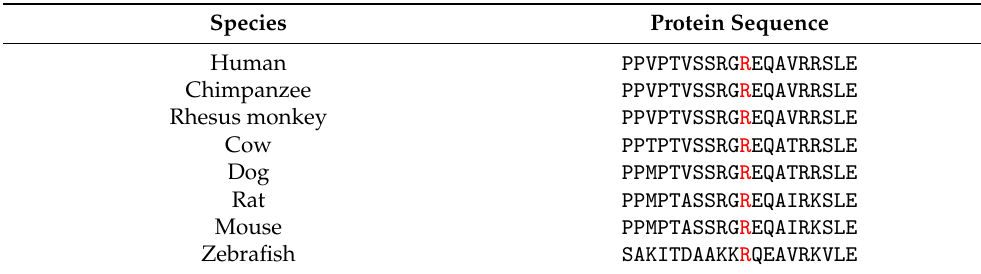
Table 1. Evolutionary conservation of the altered amino acid in the FAM161A gene. The arginine (R, marked in red) that is altered in the analyzed nonsense mutation is fully conserved through all species. Accession numbers of protein sequences are: human (NP_001188472), chimpanzee